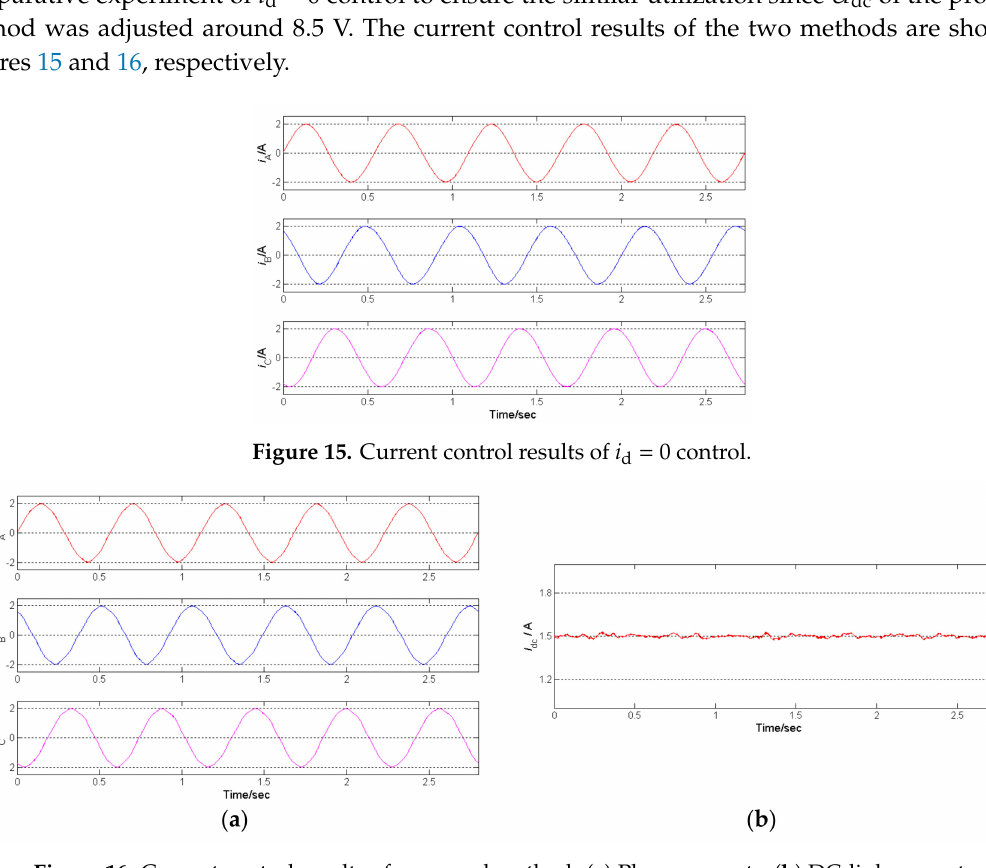
Figure 16. Current control results of proposed method. ( a ) Phase currents; ( b ) DC-link